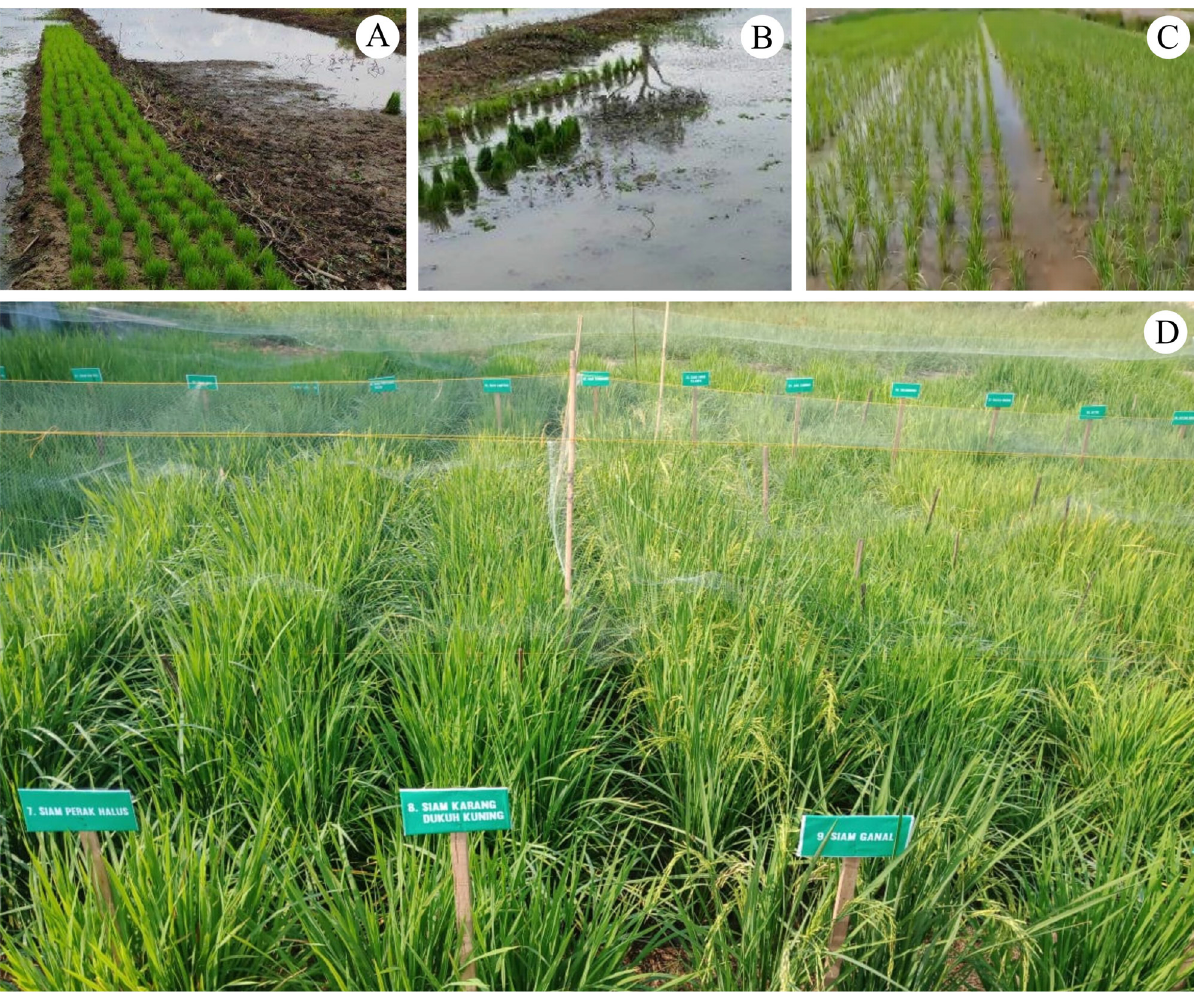
Figure 5. Cultivation of Indonesian swamp rice germplasm at the ISARI Research Station in South Kalimantan. A: seedlings grown from seeds planted in slightly dry soil on the edge of a swamp rice field; B: seedlings after translocation to the planting site; C: four-week old rice seedlings after planting out; D: flowering plants protected from birds by para-net